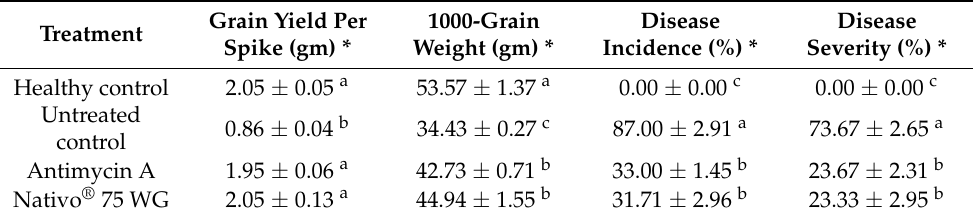
Figure 7. Suppression of wheat blast symptoms with antimycin A and Nativo ® 75 WG. Herein, ( a ) non-inoculated, non-treated seedlings as a healthy control, ( b ) water control + MoT, ( c ) antimycin A at 10 µg/mL + MoT inoculation, and ( d ) blast lesions suppressed by commercial dose of Nativo ® 75 WG. In inset, clear images of representative spike samples are presented. Table 3. Effect of antimycin A on yield or yield components of the wheat variety BARI Gom-26 under field conditions after artificial inoculation with wheat blast fungus.